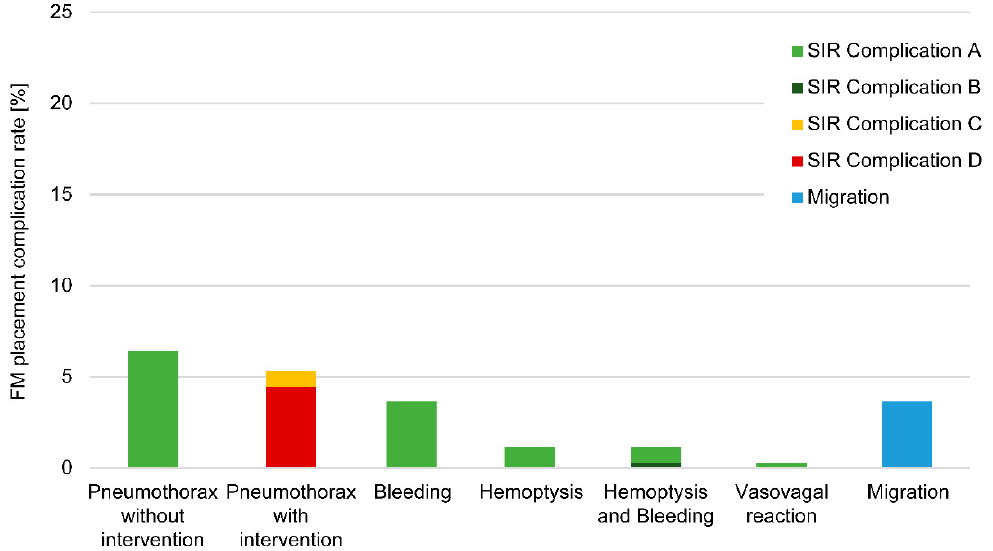
Figure 1. Complications and fiducial marker (FM) migrations. The complication rate of 357 FM placements is shown according to the Society of Interventional Radiology (SIR) classifications.